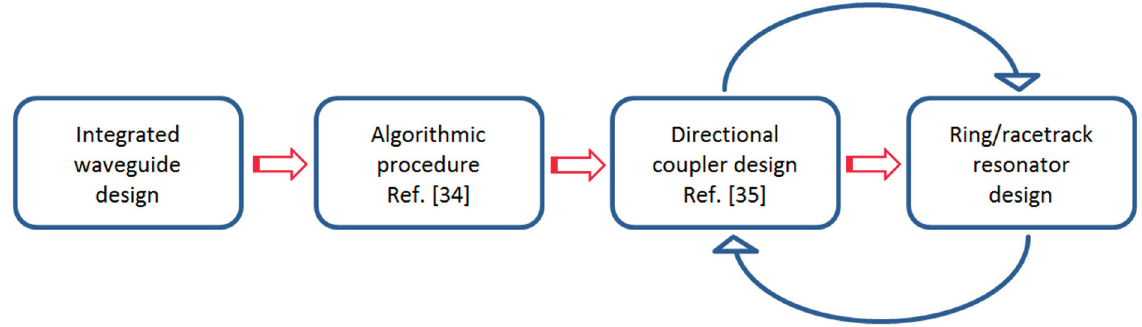
Figure 1. Diagram of the design flow for Vernier devices based on cascade-coupled ring/racetrack resonators for high-performance refractive index